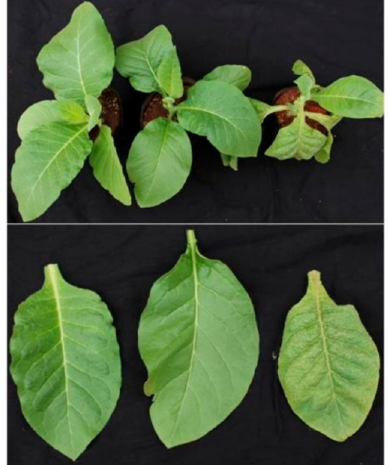
Figure 2. Phenotypes of wild-type ‘Yunyan87’, PVY (potato virus Y) resistant cultivar ‘TN86’, and M3 progeny of line 918P 23 days post PVY viral inoculation. Top panel from left to right: PVY resistant cultivar ‘TN86’, M3 progeny of line 918P, wild-type ‘Yunyan87’; bottom panel from left to right: leaf sample of PVY resistant cultivar ‘TN86’, leaf sample of M3 progeny of line 918P, leaf sample of wild-type